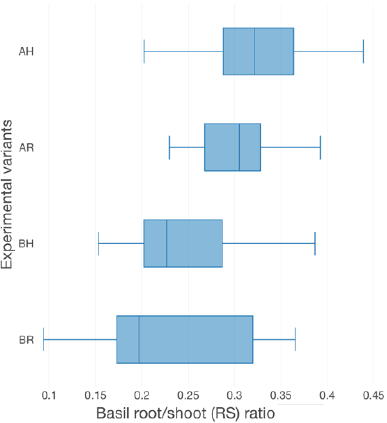
Figure 6. Boxplot for basil root/shoot ratio (R/S) for each experimental variant, at the end of the trial. Therefore, in terms of basil height, the AR experimental variant registered the highest average value (57.67 ± 9.96 cm), followed by AH (61.40 ± 10.24 cm), BR (43.67 ± 5.59 cm) and BH (39.44 ± 6.42 cm). Significant statistical differences ( p < 0.05) are registered between